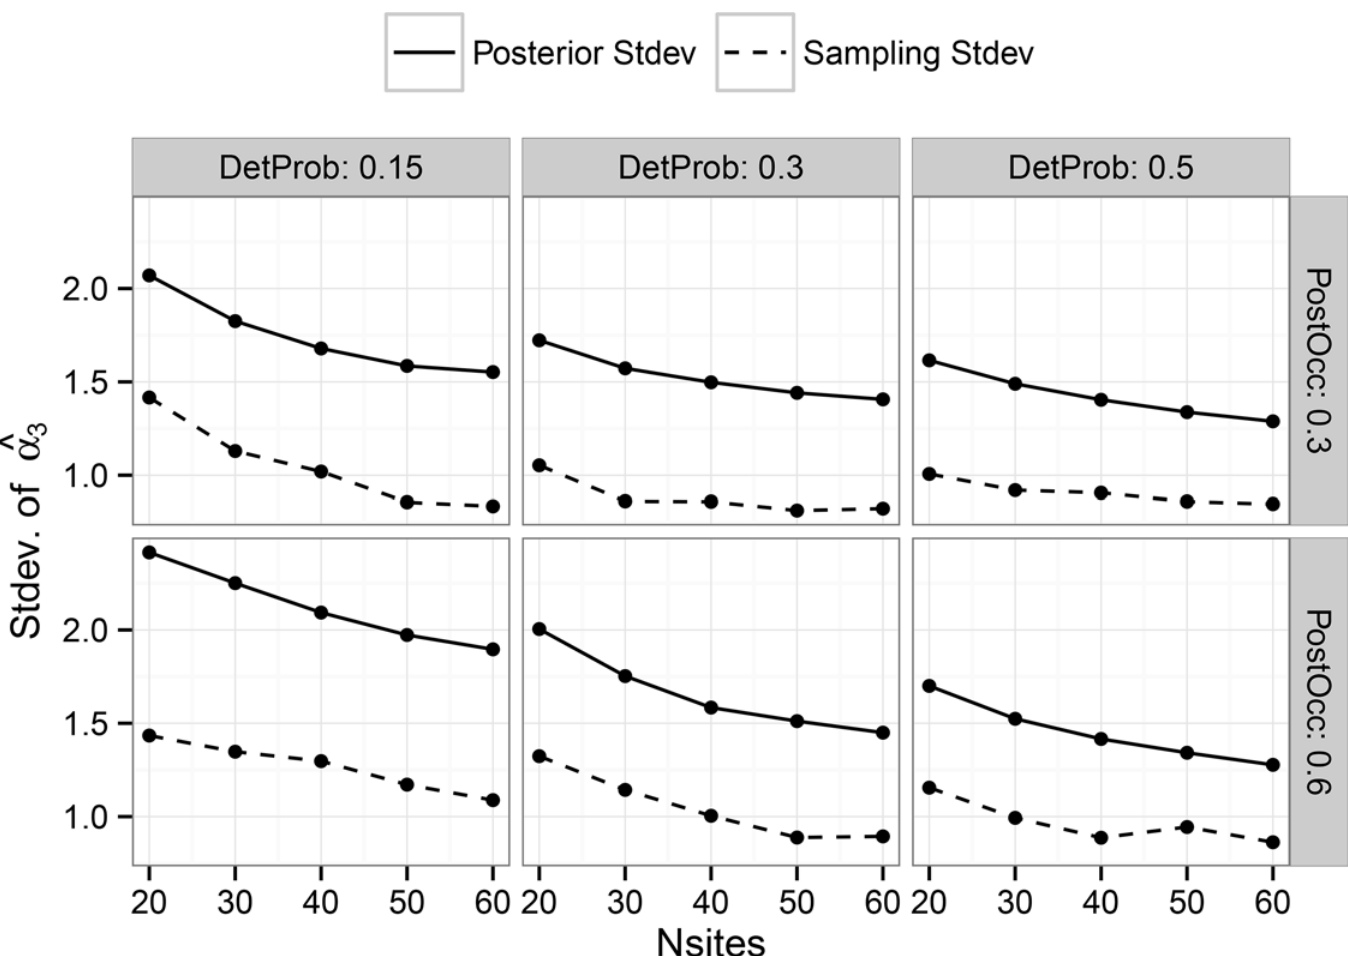
Fig 6. Comparison of the standard deviation of posterior mean estimates of ‘ Alpha3 ’ vs. the average posterior standard deviation of ‘ Alpha3 ’ in the multi-scale model. Results are shown only for combinations with seven plots. Results for five and nine plots are not shown, but have trends similar to those shown here. Panels show the results for different combinations of detection probability and post-treatment